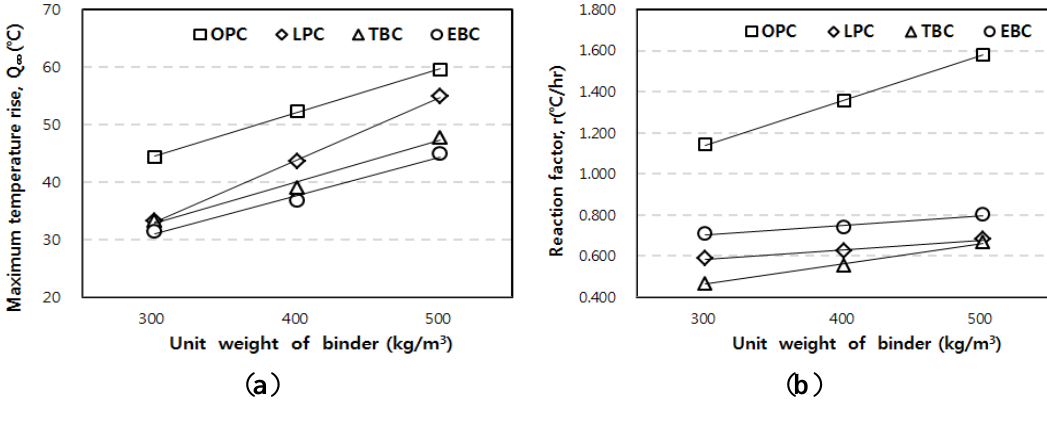
Figure 5. Results of the adiabatic temperature rise test for ( a ) maximum temperature rise; and ( b ) reaction